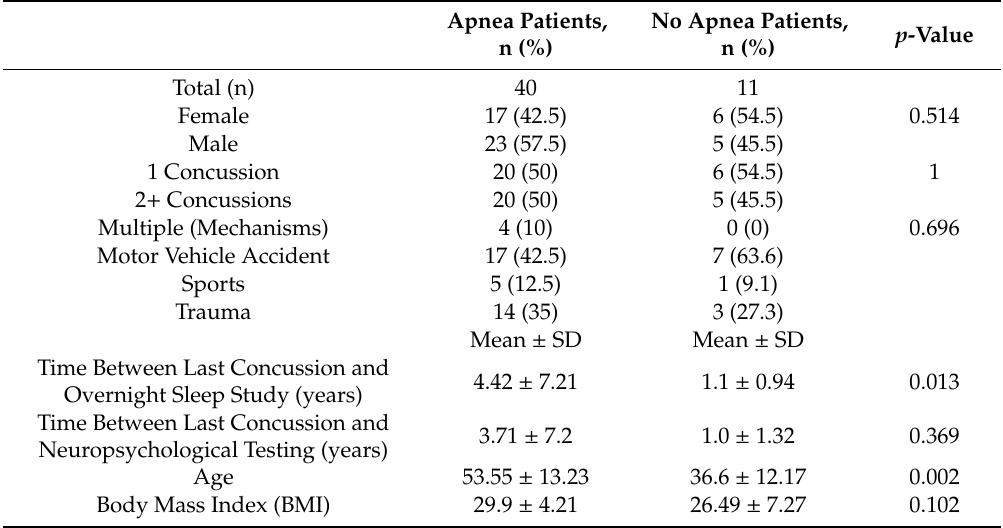
Figure 1. Flow of patient selection and exclusion. * Sleep complaints are (1) the patient complaining of non-restorative sleep and / or (2) waking up with headaches.